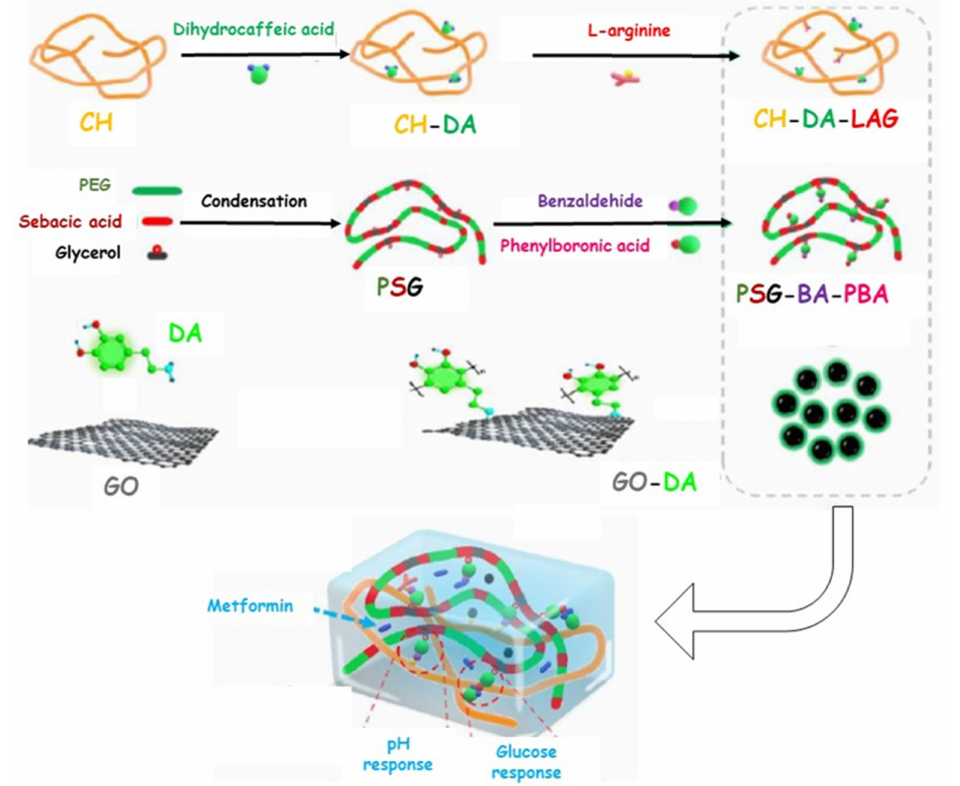
Figure 4. CH-based multifunctional hydrogel for diabetic wound treatment. Preparation of dihydro- caffeic acid (DA) and L-arginine (LAG) co-grafting chitosan (CS-DA-LAG) and phenylboronic acid (PBA) and benzaldehyde (BA) difunctionalized polyethylene glycol-co-poly(glycerol sebacic acid) (PSG) and coated graphene oxide (GO-DA)